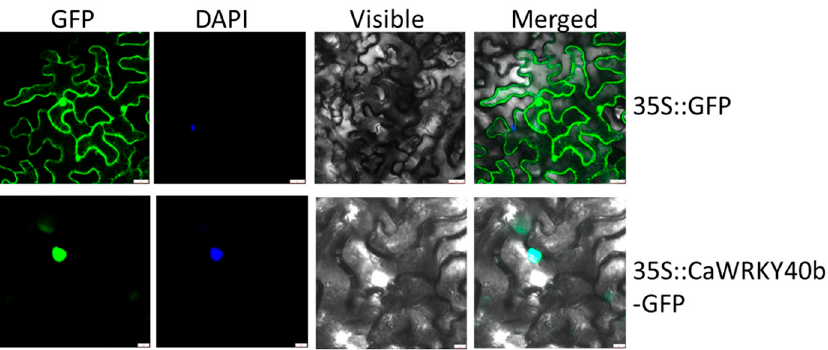
Figure 2. Subcellular localization of CaWRKY40b. The leaves of 50-day-old Nicotiana benthamiana plants were infiltrated with Agrobacterium strain GV3101 cells containing the 35S:CaWRKY40b-GFP and 35S:GFP construct, respectively. After 48 hpi, GFP fluorescence was imaged under a confocal microscope. The GFP signals in leaves infiltrated with GV3101 cells containing the 35S:CaWRKY40b-GFP were observed in the nuclei, while that in leaves infiltrated with GV3101 cells containing 35S:GFP construct were observed throughout the cell. DAPI, 4 ′ ,6-diamidino-2-phenylindole; GFP, green fluorescent protein, bar = 25 µm.